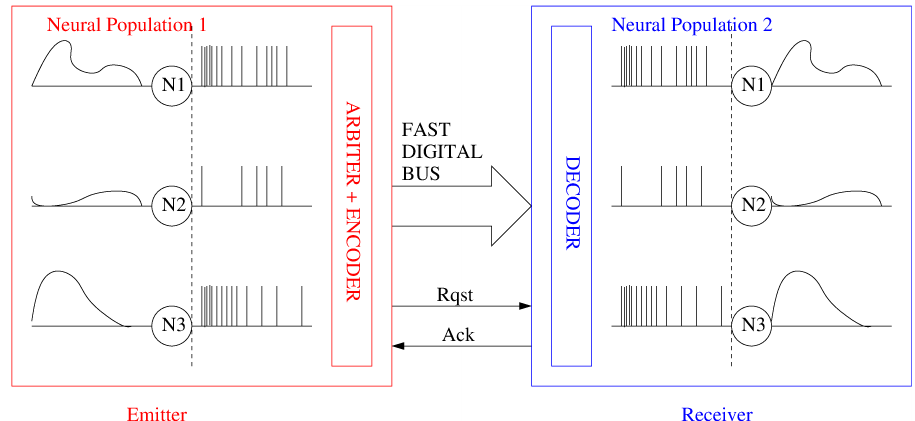
Figure 5. Illustration of two neural populations communicated through a point-to-point AER bus. Each neuron in the emitter population can be virtually connected to every neuron in the receiver